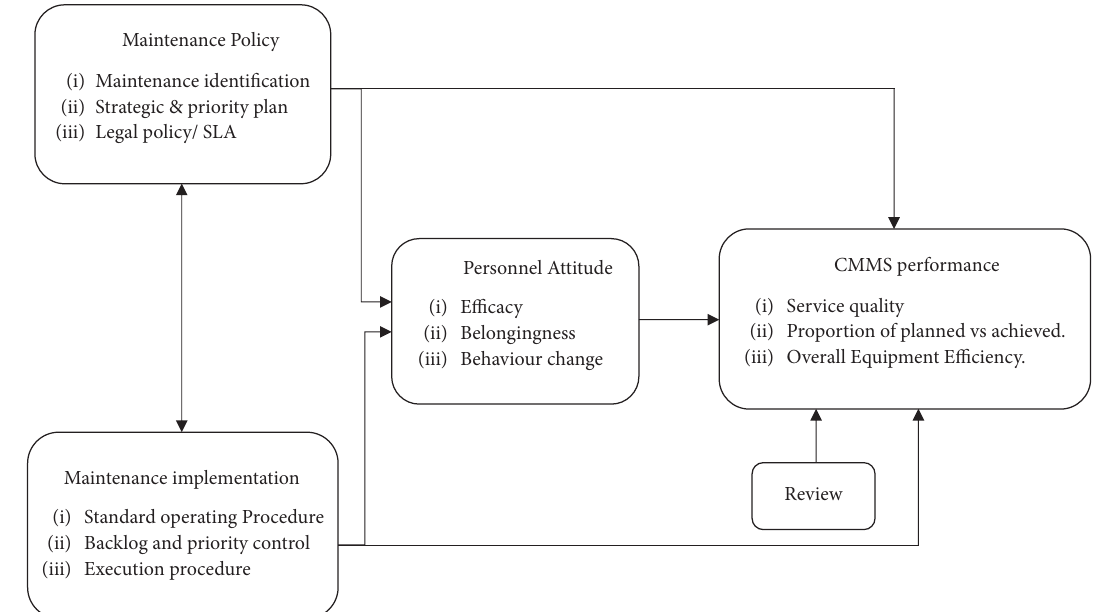
Figure 1: Theoretical framework for CMMS